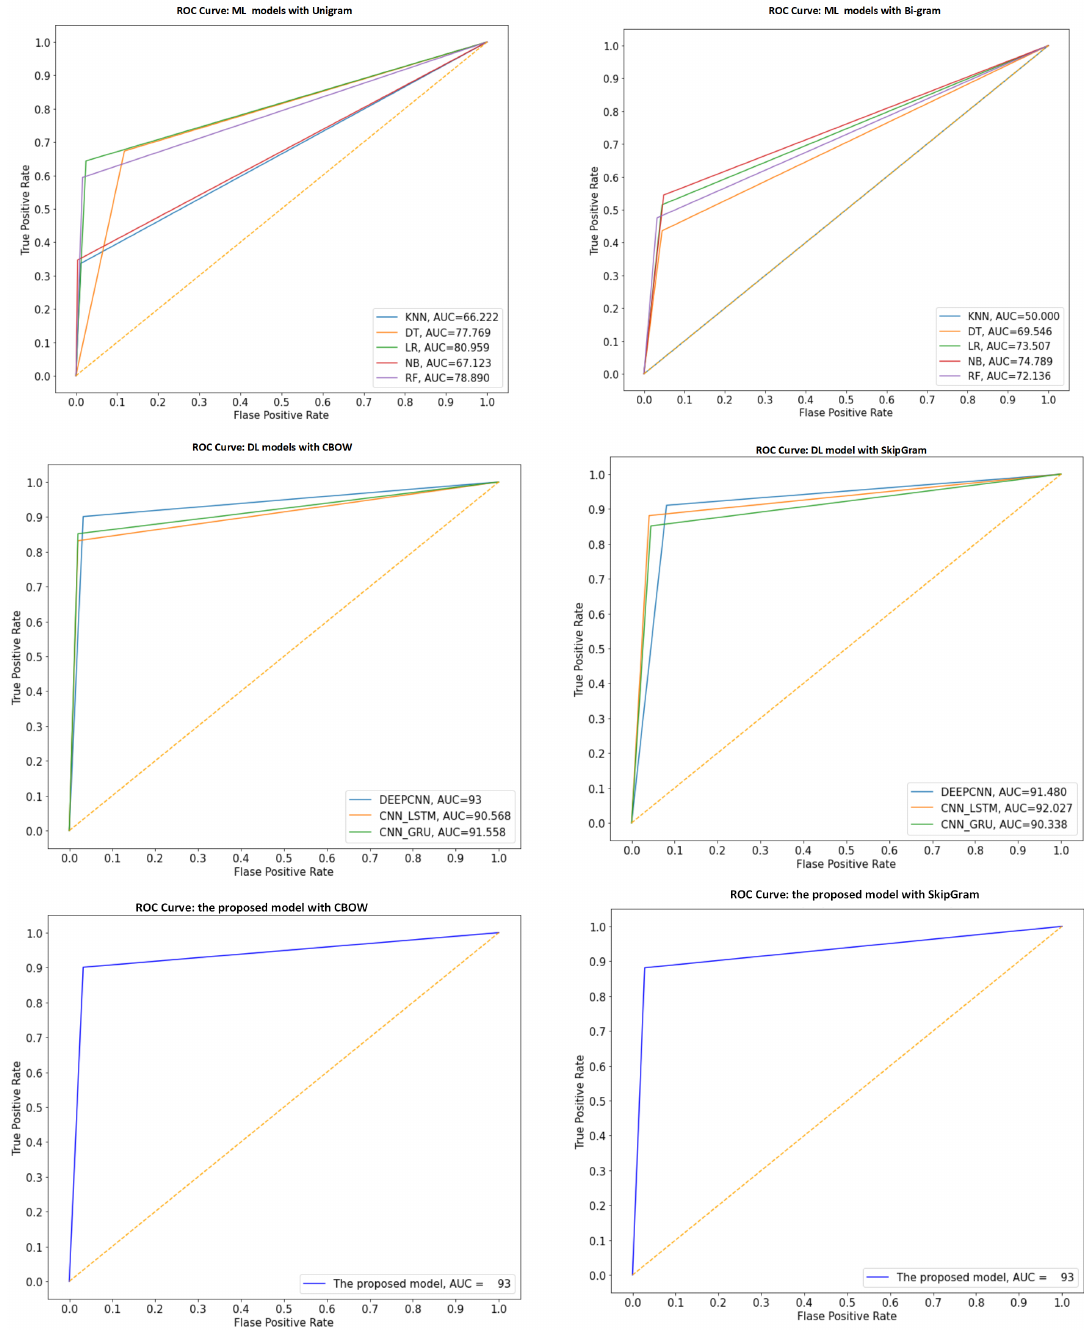
Figure 6. The ROC curve and AUC scores for the Sub-AHS